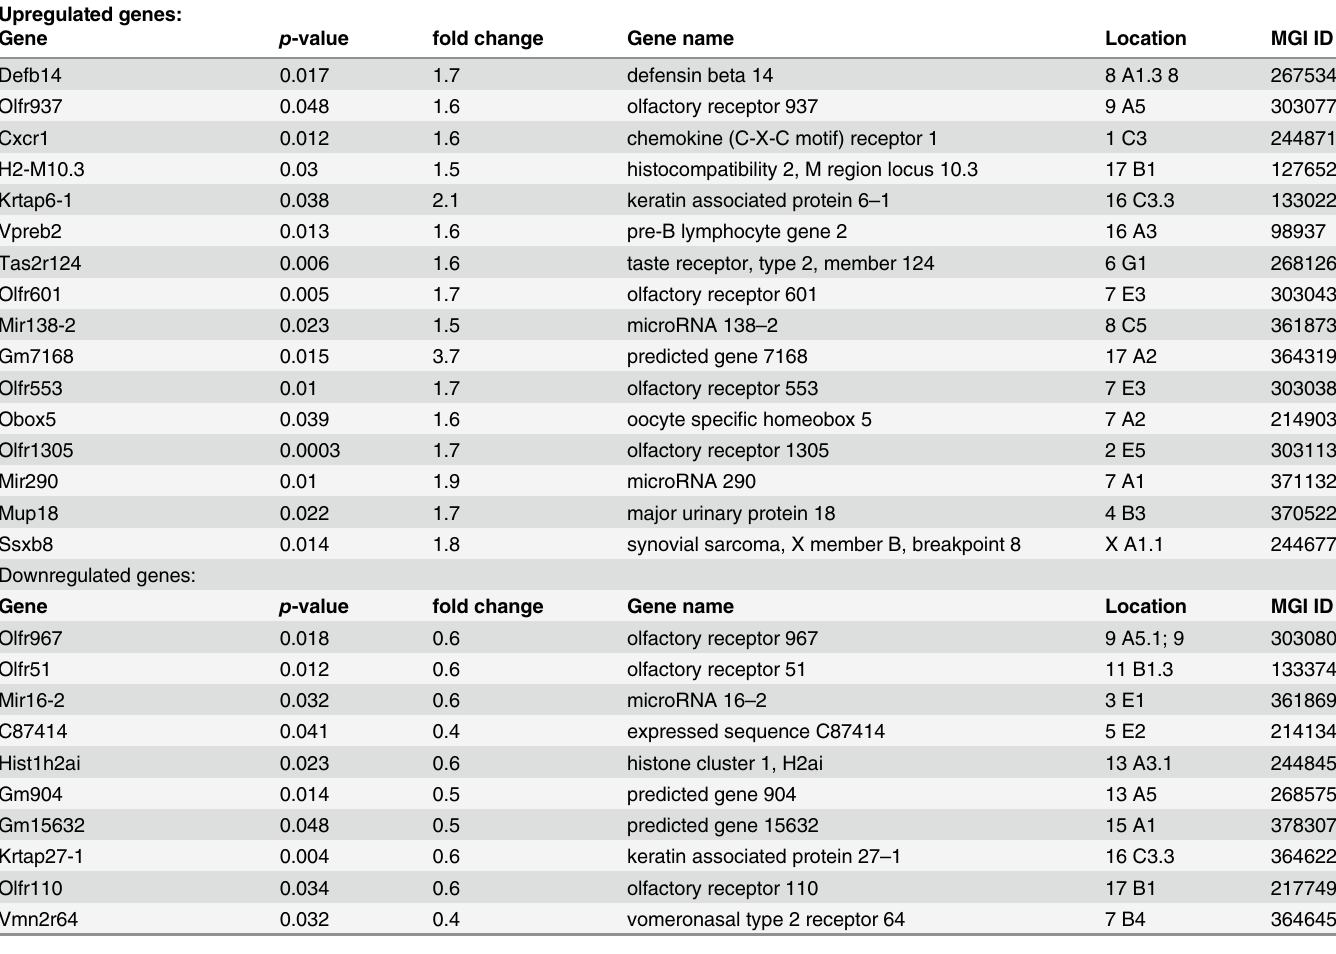
Table 1. Altered gene expression of 23 genes and three microRNAs in hippocampus of ethanol-exposed offspring (P28). Upregulated genes: